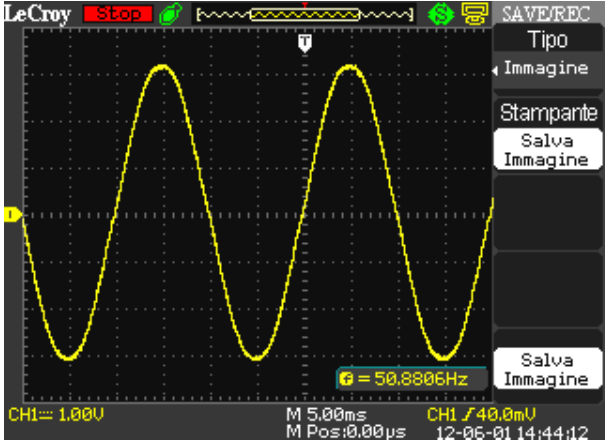
Figure 16. Input AC sinusoidal voltage.